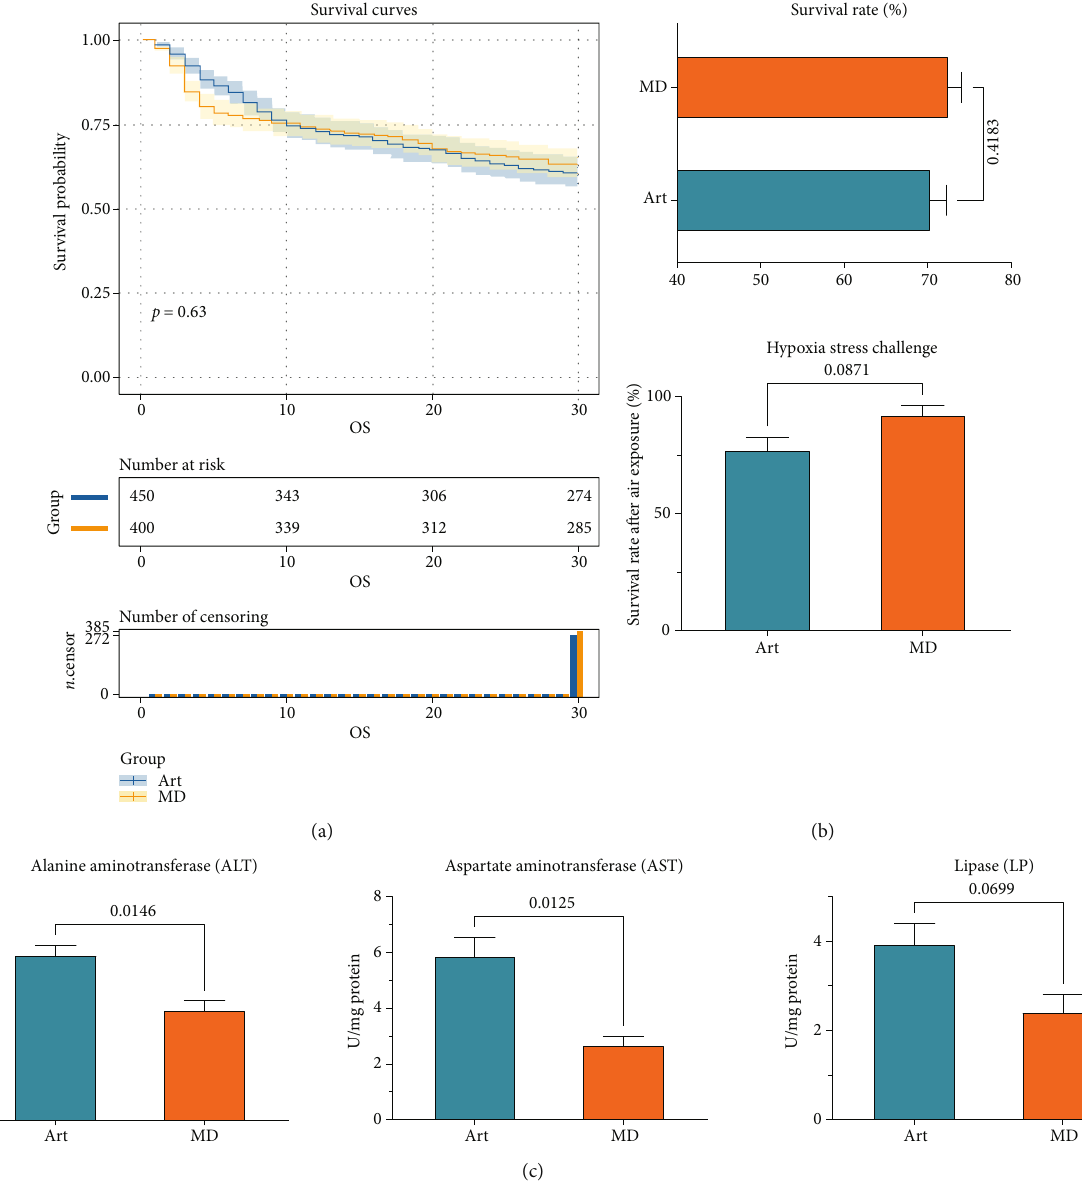
Figure 1: Rock bream larval survival rate, hypoxia stress resistance, and liver tissue metabolism-related enzyme activities. (a) Daily data on the rock bream larval survival rate were collected during the feeding study. The right panel displays the results of the statistical analysis. (b) Larval stress tolerance after 300 seconds of air exposure. (c) Larval liver tissue amino acid metabolism-related and lipid metabolism-related enzyme activity corresponds to Artemia and